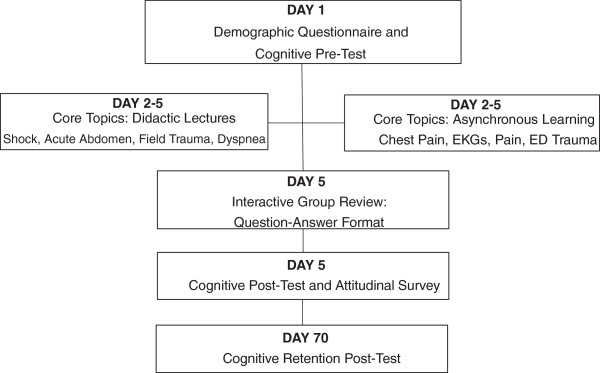
Study flowchart.